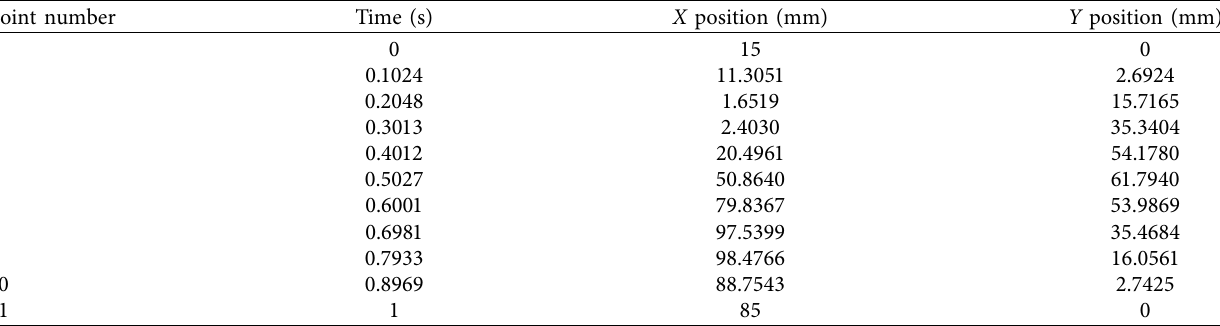
Figure 13: Model of fitness calculation system. Table 7: Corresponding trajectory points obtained by PSO.